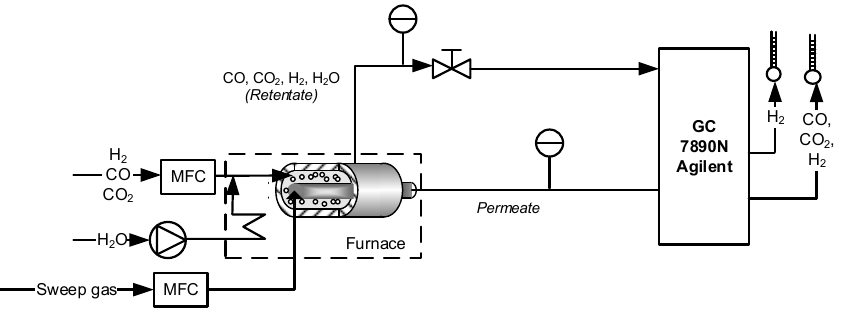
Figure 8. Scheme of the packed bed membrane reactor set up used for the Water Gas Shift (WGS) lab scale demonstration.